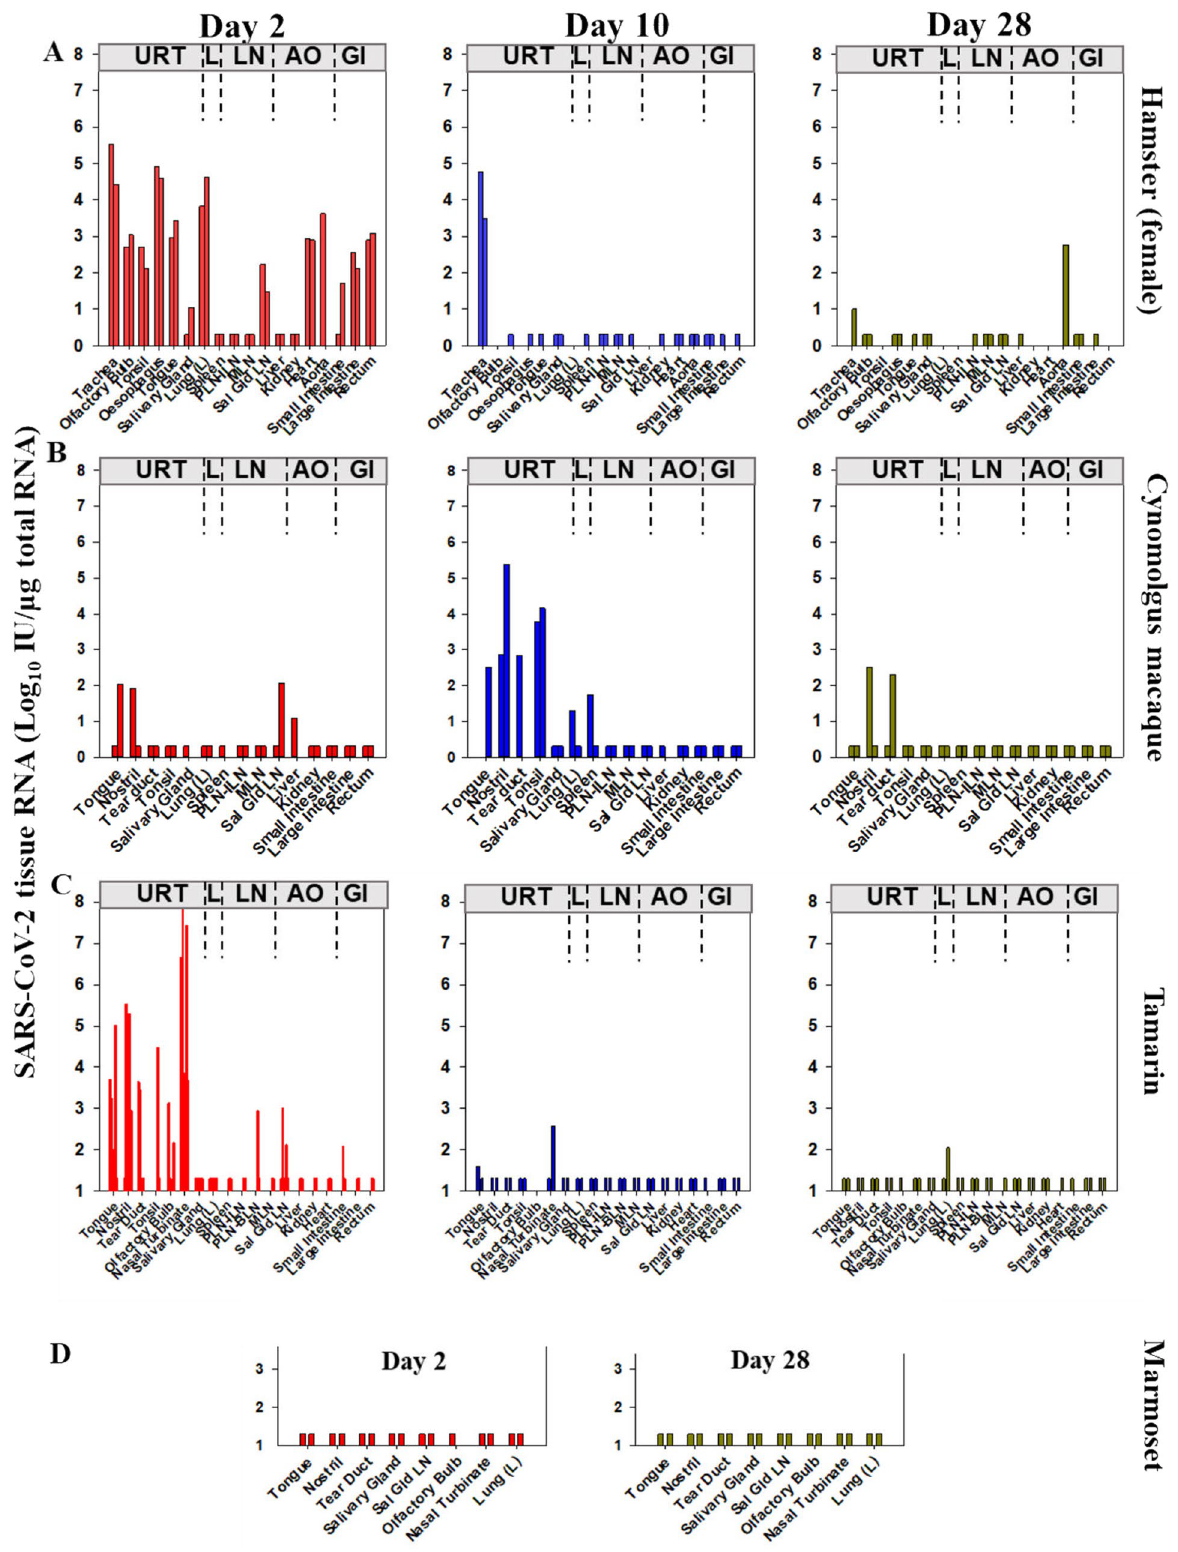
Figure 3. Anatomical biodistribution of SARS-CoV-2 genomic RNA. Multiple tissue extracts analysed for SARS- CoV-2 RNA expressed as Log 10 International Units (IU)/µg total RNA. ( A ) female hamsters compared across the 2, 10 and 28 dpi time-course in multiple tissues from upper respiratory tract (URT), lung (L), lymphatic organs (LN), major abdominal organs (AO) and the gastrointestinal tract (GI); ( B ) cynomolgus macaque and ( C ) tamarins with a comparable set of tissues as indicated. ( D ) marmosets assayed at days 2 and 28 for a range of upper airway tissues and lung. Bars indicate tissues analysed which varied slightly across species; vertical bars up to the limit of detection of log 10 20 IU/µg total RNA indicate where a tissue was analysed but a negative result